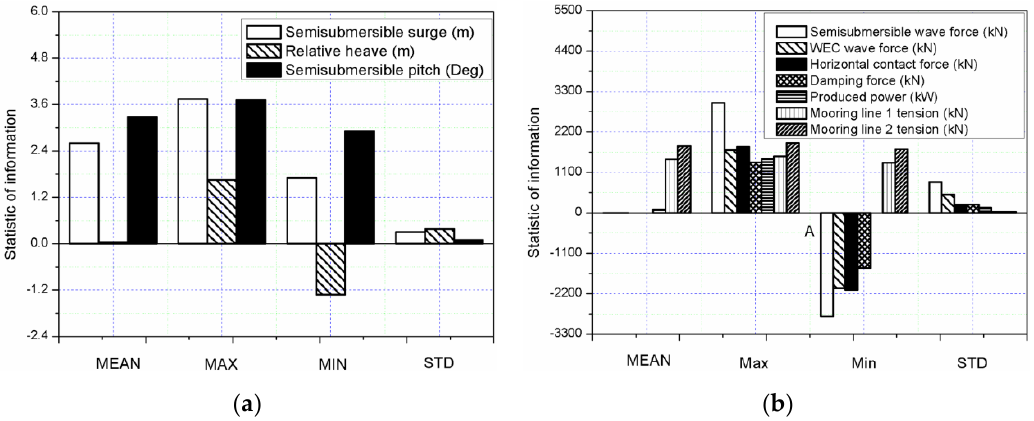
Figure 17. Statistical values of the responses for LC3: ( a ) statistic of information for semisubmersible surge, relative heave and pitch; ( b ) statistic of information for semisubmersible wave force, WEC wave force, horizontal contact force, damping force, produced power, mooring line 1 tension and mooring line 2 tension.